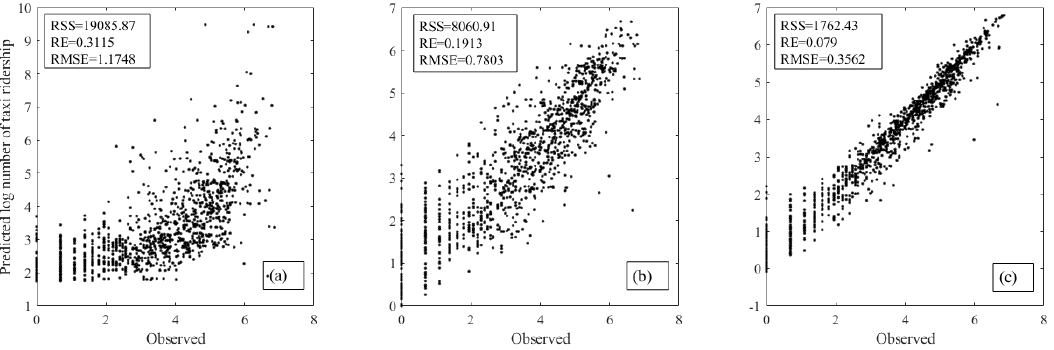
Figure 7. Scatter plots for model fitting and cross validation. ( a ) OLS; ( b ) GWR; and ( c ) GTWR.